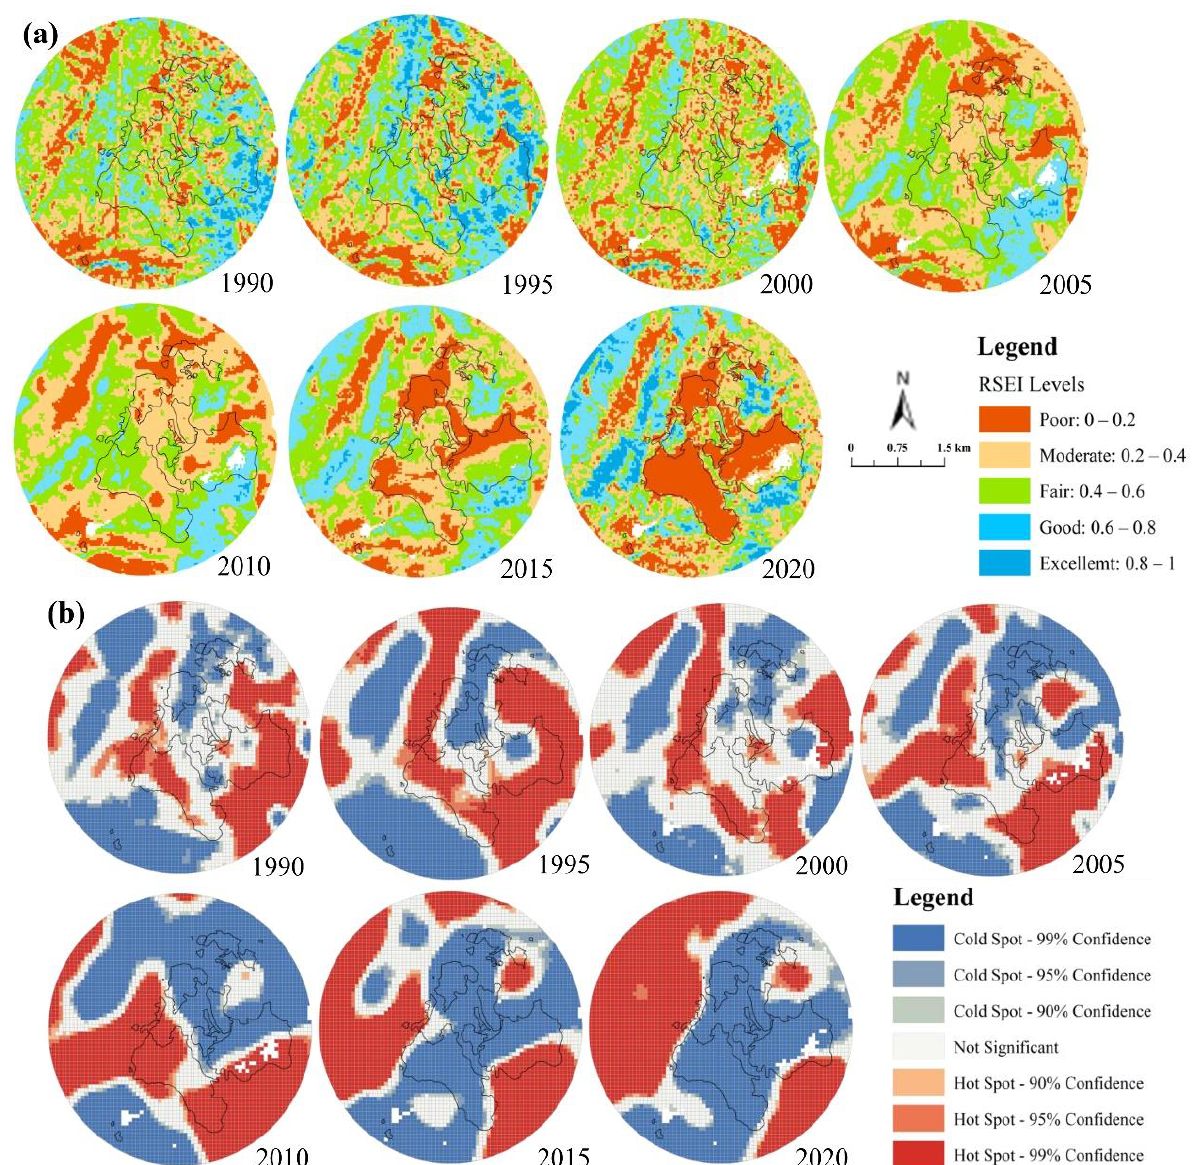
Figure A1. Spatial Distribution of RSEI and Hotspots and Coldspots in Baima Mine (( a ): Spatial Distribution of RSEI, ( b ): Spatial Distribution of Hotspots and Coldspots).